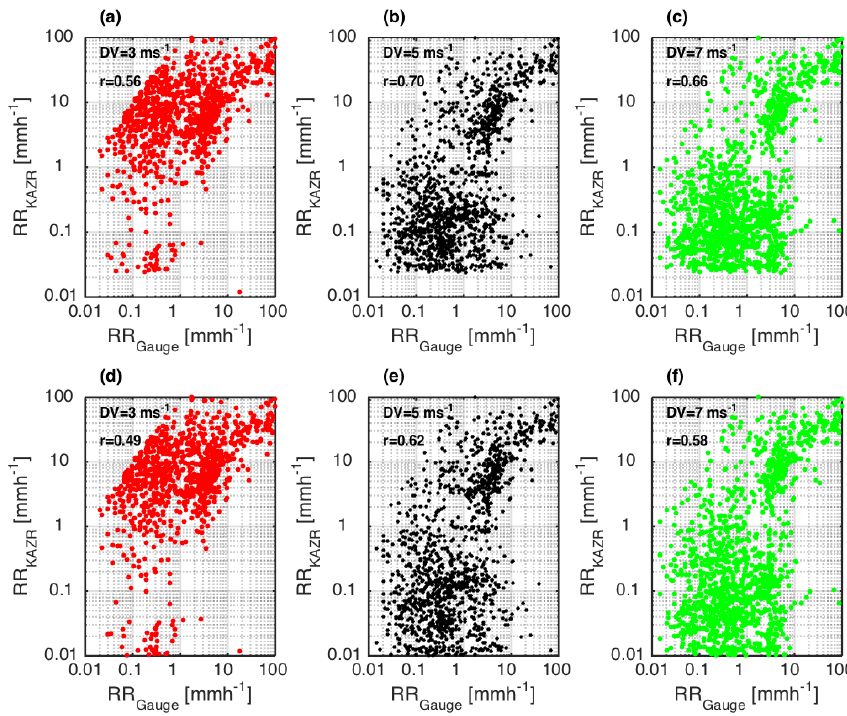
Figure 8. Scatter plot of observed rain rates from an optical gauge vs. rain rates retrieved from the KAZR using the Z e – R relations developed from the disdrometer (a–c) and the KAZR (d–f) for different Doppler velocity thresholds (DV thresh ) . The samples covering 15 days of rain events between 8 October 2011 and 6 February 2012. Rain rates from the KAZR are retrieved using both Z e – R (for DV< = DV thresh ) and A – R (for DV>DV thresh ) methods for different Doppler velocity thresholds (3, 5, and 7ms − 1 ) shown in the legend. The Z e – R relations are applied separately for the stratiform and convective rain events. The list of Z e – R coefficients and exponents for different rain types are summarized in Table 3.